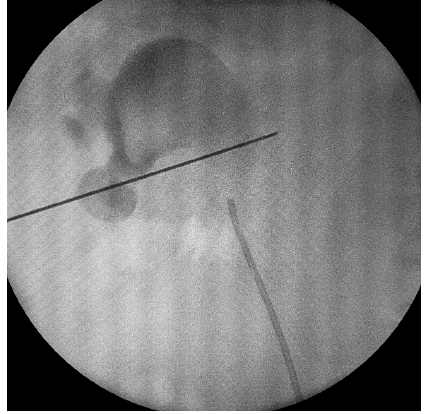
Figure 1. Targeting of the puncture site.